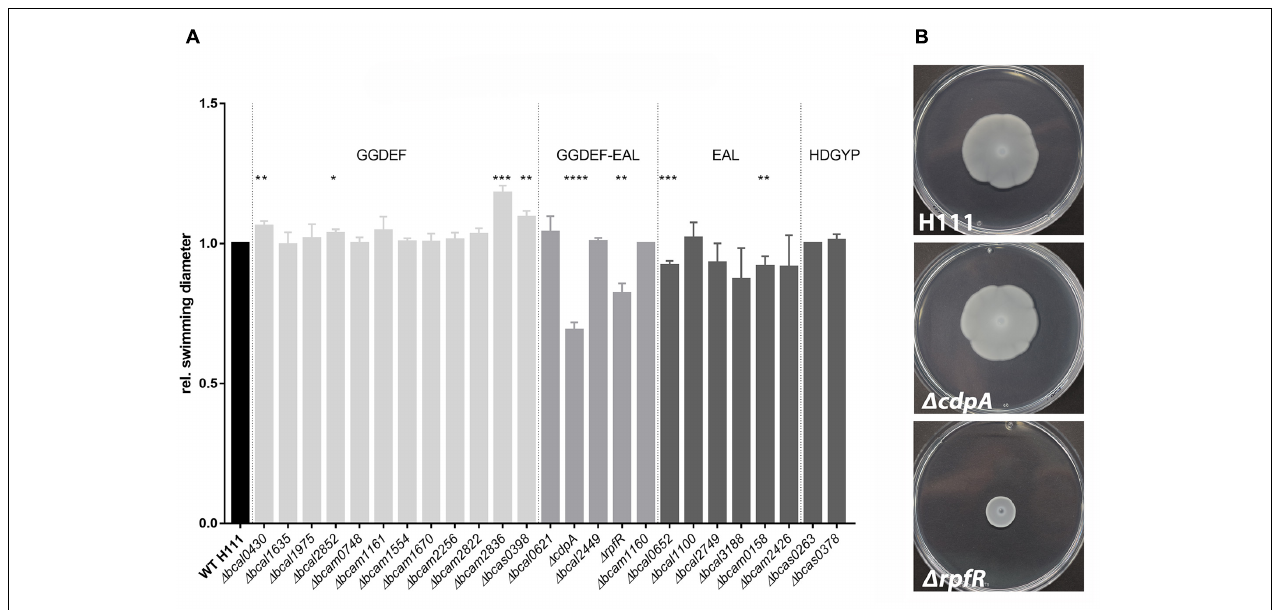
FIGURE 2 | Motility of B. cenocepacia H111 and PDE/DGC mutants in semi-solid medium. (A) Swimming motility. Overnight cultures of B. cenocepacia H111 and mutant derivatives were adjusted to OD 600 4 and inoculated into swim plates. Plates were incubated at 37 ◦ C and the relative swimming diameter was measured after 10 h. Strains with disruption of genes encoding GGDEF-only proteins are highlighted in light gray, composite GGDEF-EAL protein mutants in gray, EAL-only and HD-GYP-domain protein mutants in dark gray, respectively. Data was normalized to wild type results and shows mean swimming diameter and standard derivations of three individual experiments. Asterisks indicate P < 0.05 with unpaired t -test. (B) Swarming motility. Overnight cultures of B. cenocepacia H111 and mutant derivatives were adjusted to OD 600 4.0 and inoculated on top of a swarm plate. Plates were incubated at 37 ◦ C and pictures were captured after 24 h. Data shown here are representatives of three independent